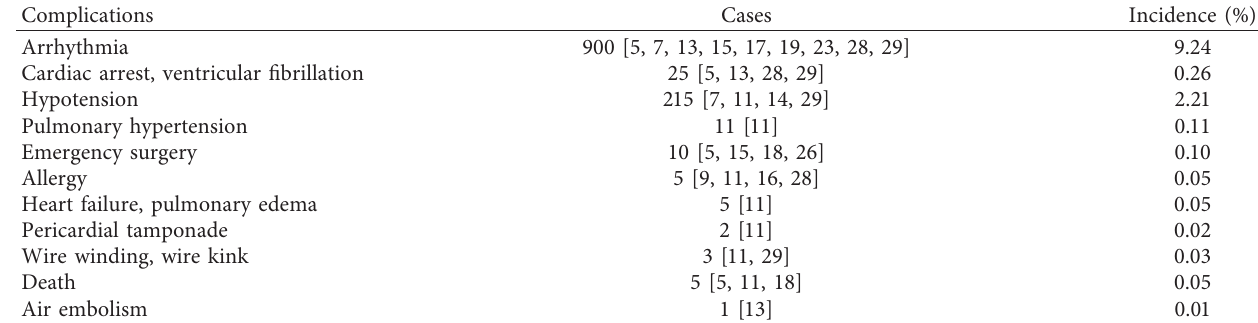
Table 5: Procedure-related complications.